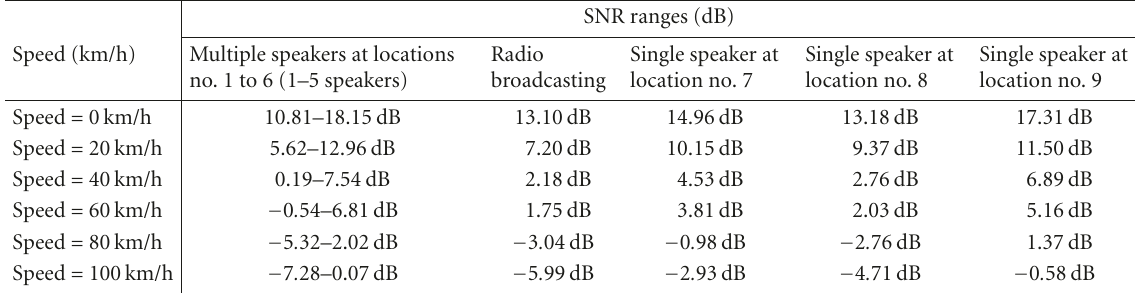
Table 2: SNR ranges at various speeds.